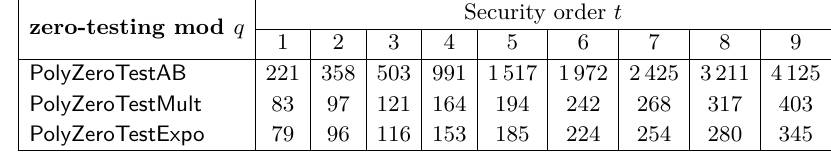
Table 5: Running time in thousands of cycles for a C implementation on Intel(R) Core(TM) i7-1065G7, for the same parameters as in Table